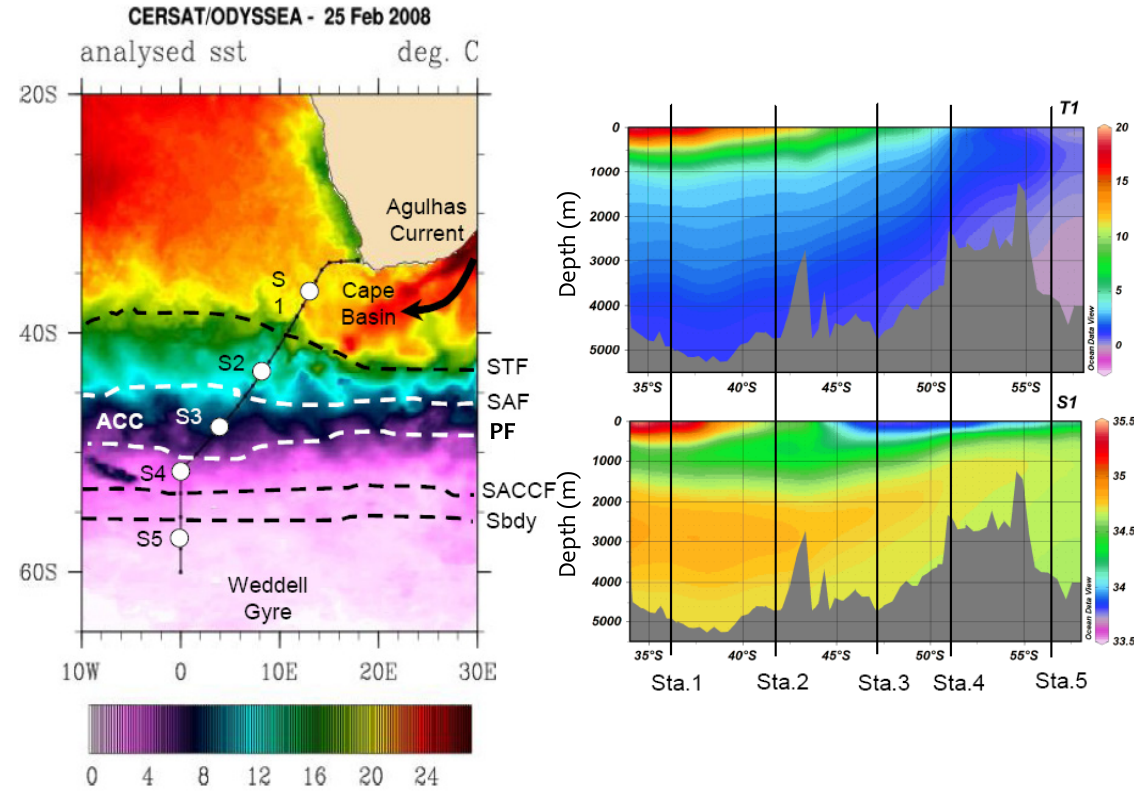
Fig. 1. Left part of panel=BONUS-GoodHope voyage track and station locations (S1 at 36 ◦ 31 0 S; S2 at 42 ◦ 28 0 S; S3 at 47 ◦ 33 0 S; S4 at 51 ◦ 52 0 S; S5 at 57 ◦ 33 0 S). The background is sea surface temperature SST ( ◦ C) from the CERSAT/ODYSSEA satellite. A SST scale is given at the bottom of the image. The SST north–south gradient is typical of the region in summer. Approximate location of ACC fronts in summer (STF=Sub-Tropical Front, SAF=Sub-Antarctic Front North, PF=Polar Front, SACCF=South Antarctic Circumpolar Current Front, Sbdy=southern boundary of the ACC) are shown. The area north of the STF is the Sub-Tropical Zone (STZ); the Sub-Antarctic Zone (SAZ) is located between STF and SAF; the Polar Front Zone (PFZ) is located between the SAF and PF; the Antarctic Zone (AZ) is located between the PF and Sbdy, and south of the Sbdy is identified as the northern part of the Weddell Gyre (WG). Right part of panel=Complete salinity S1 PSU (lower panel) and temperature T 1 ( ◦ C, upper panel) sections during BGH (from BGH cruise report; courtesy from S. Speich). Station locations are